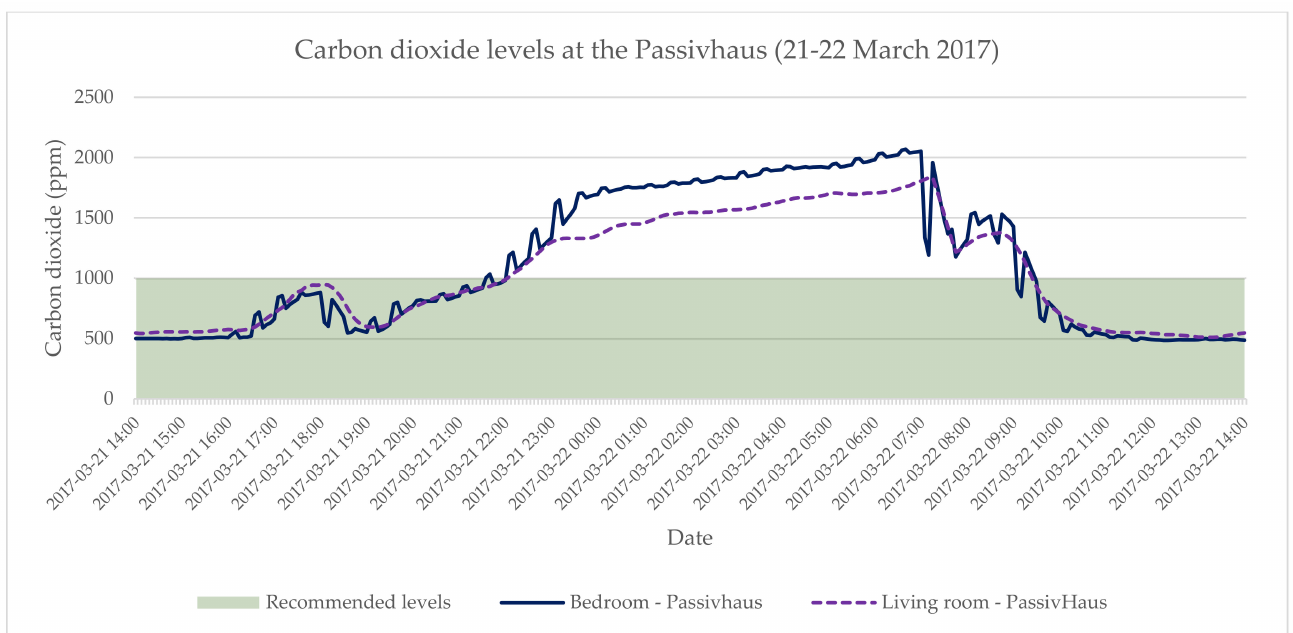
Figure 4. Monitored CO 2 levels in Mexico’s Passivhaus (21–22 March 2017). Source: